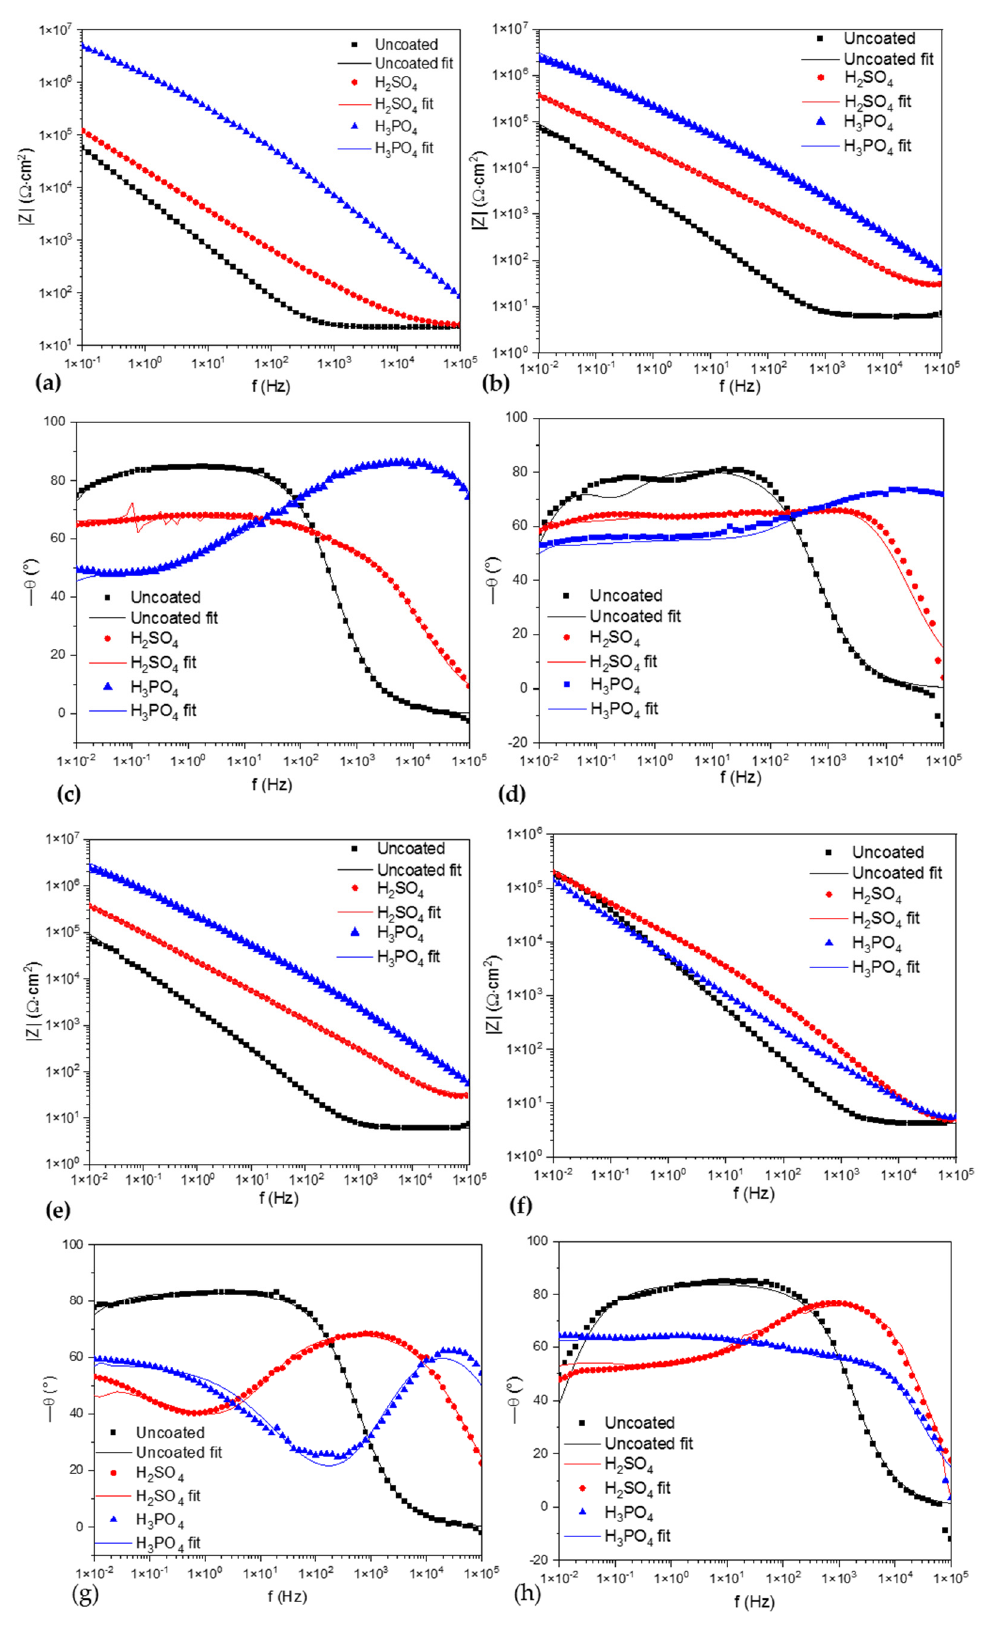
Figure 7. Bode vs. |Z|; ( a ) Ti-6Al-2Sn-4Zr-2Mo in NaCl, ( b ) Ti-6Al-2Sn-4Zr-2Mo in H 2 SO 4 , ( e ) Ti-6Al-4V in NaCl, and ( f ) Ti-6Al-4V in H 2 SO 4 . Bode diagrams vs. angle phase ( θ °); ( c ) Ti-6Al-2Sn-4Zr-2Mo in NaCl, ( d ) Ti-6Al-2Sn-4Zr-2Mo in H 2 SO 4 , ( g ) Ti-6Al-4V in NaCl, and ( h ) Ti-6Al-4V in H 2 SO 4 .